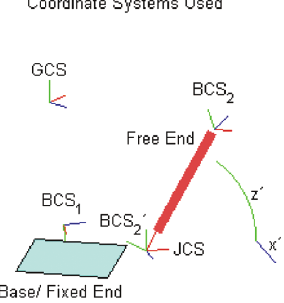
Fig. 5. Coordinate systems BCS 1 and BCS 2 give the rigid body motion of the fixed and free end respectively, in the global coordinate system (GCS). Coordinate sys- tems JCS and BCS ′ 2 are generated based on the motion of the free end. JCS is static while BCS ′ 2 rotates with the free end. The z ′ and x ′ coordinates are a flattened cylindrical coordinate system used to describe the mo- tion of